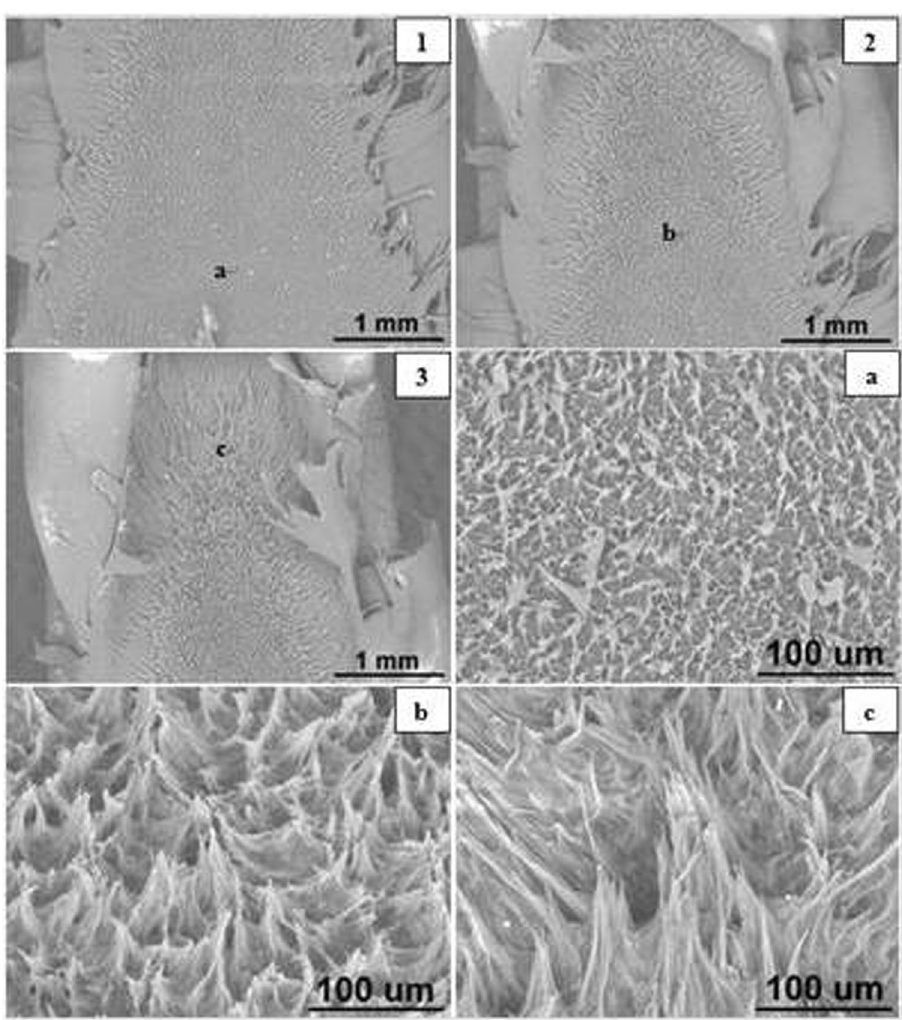
Figure 15. SEM images of sharp crack HDPE fracture surfaces at 0.05 mm/min (1) crack tip at the bottom, crack propagating from bottom to top; (2) medium propagation; (3) top of propagation at 25